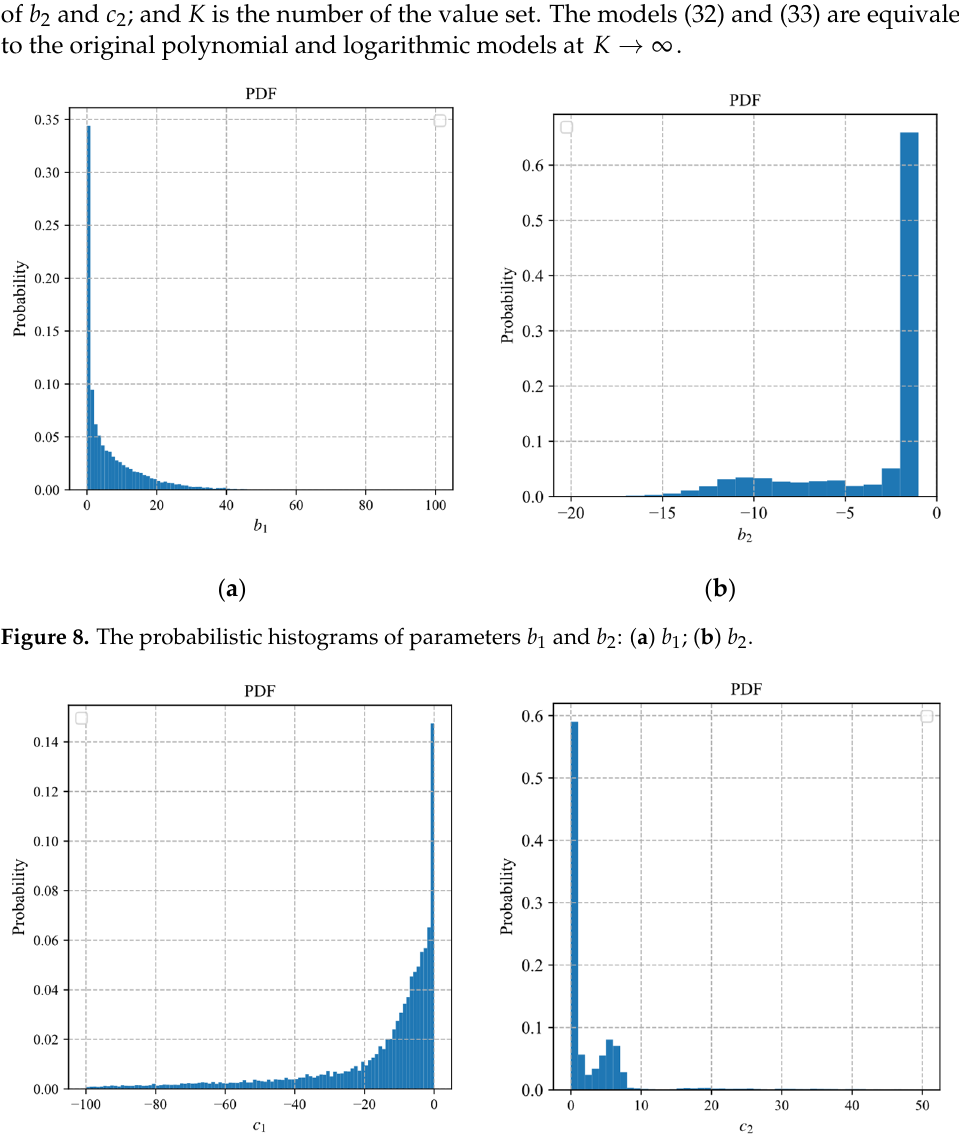
Figure 9. The probabilistic histograms of parameters